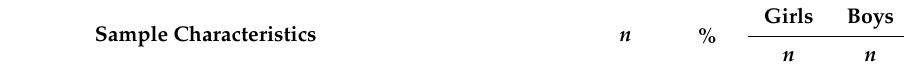
Table 1. Sociodemographic characteristics of the study